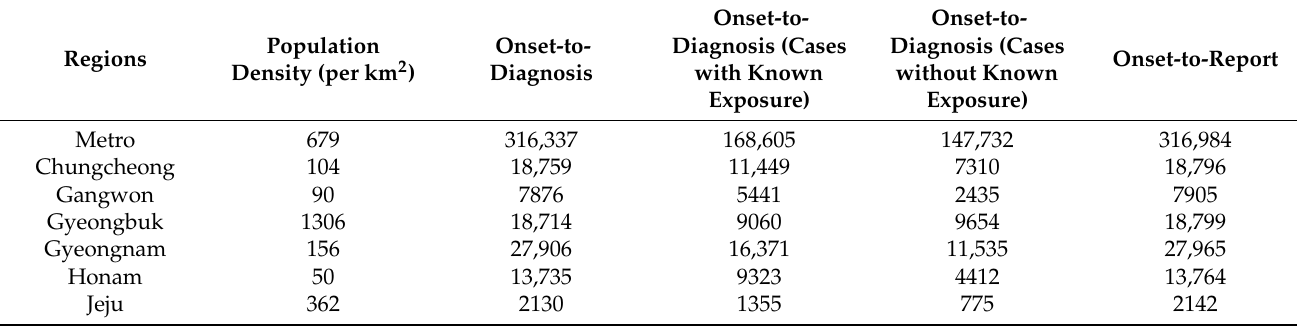
Table 2. Number of datapoints per region for each analyzed